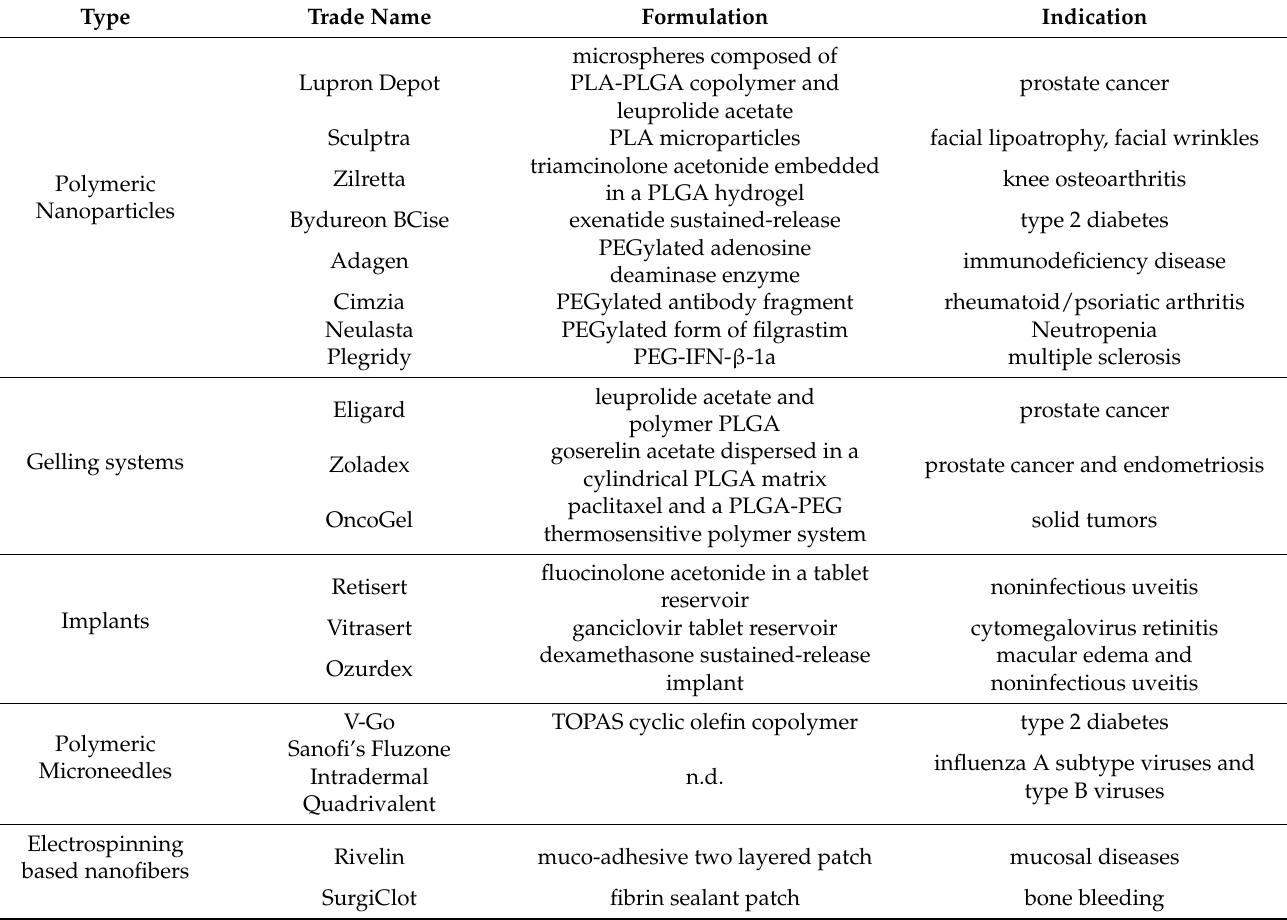
Table 3. FDA-approved polymer-based drug delivery systems described in this